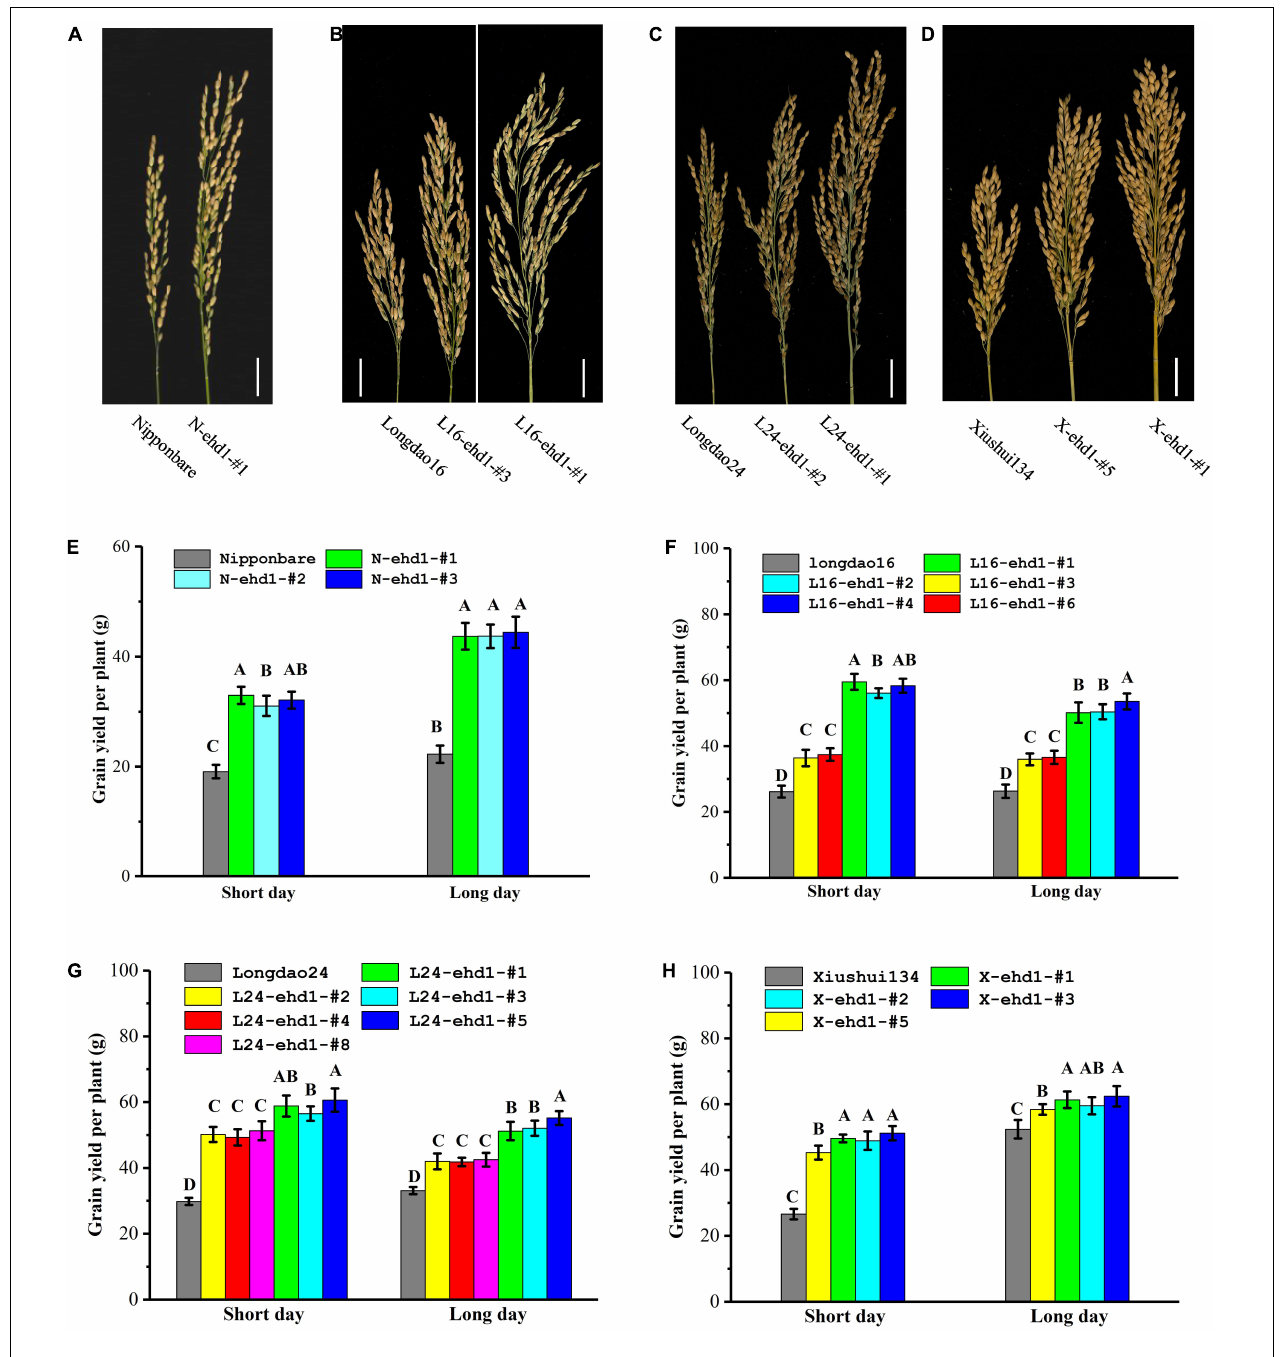
FIGURE 5 | ehd1 mutant lines exhibited high grain yield under both LD and SD conditions. (A–D) ehd1 mutant lines exhibited significantly increased panicle length and grain number per panicle in Nipponbare (A) , Longdao16 (B) , Longdao24 (C) , and Xiushui134 (D) backgrounds, respectively. Pictures were taken at Fuzhou experimental station under long day condition. Scale bar: 2 cm. (E–H) Statistical analysis for grain yield per plant of ehd1 mutant lines in Nipponbare (E) , Longdao16 (F) , Longdao24 (G) , and Xiushui134 (H) backgrounds. Data were collected from 10 plants. The letters A, B, C, and D indicates the significant differences according to LSD multiple range test at P ≤